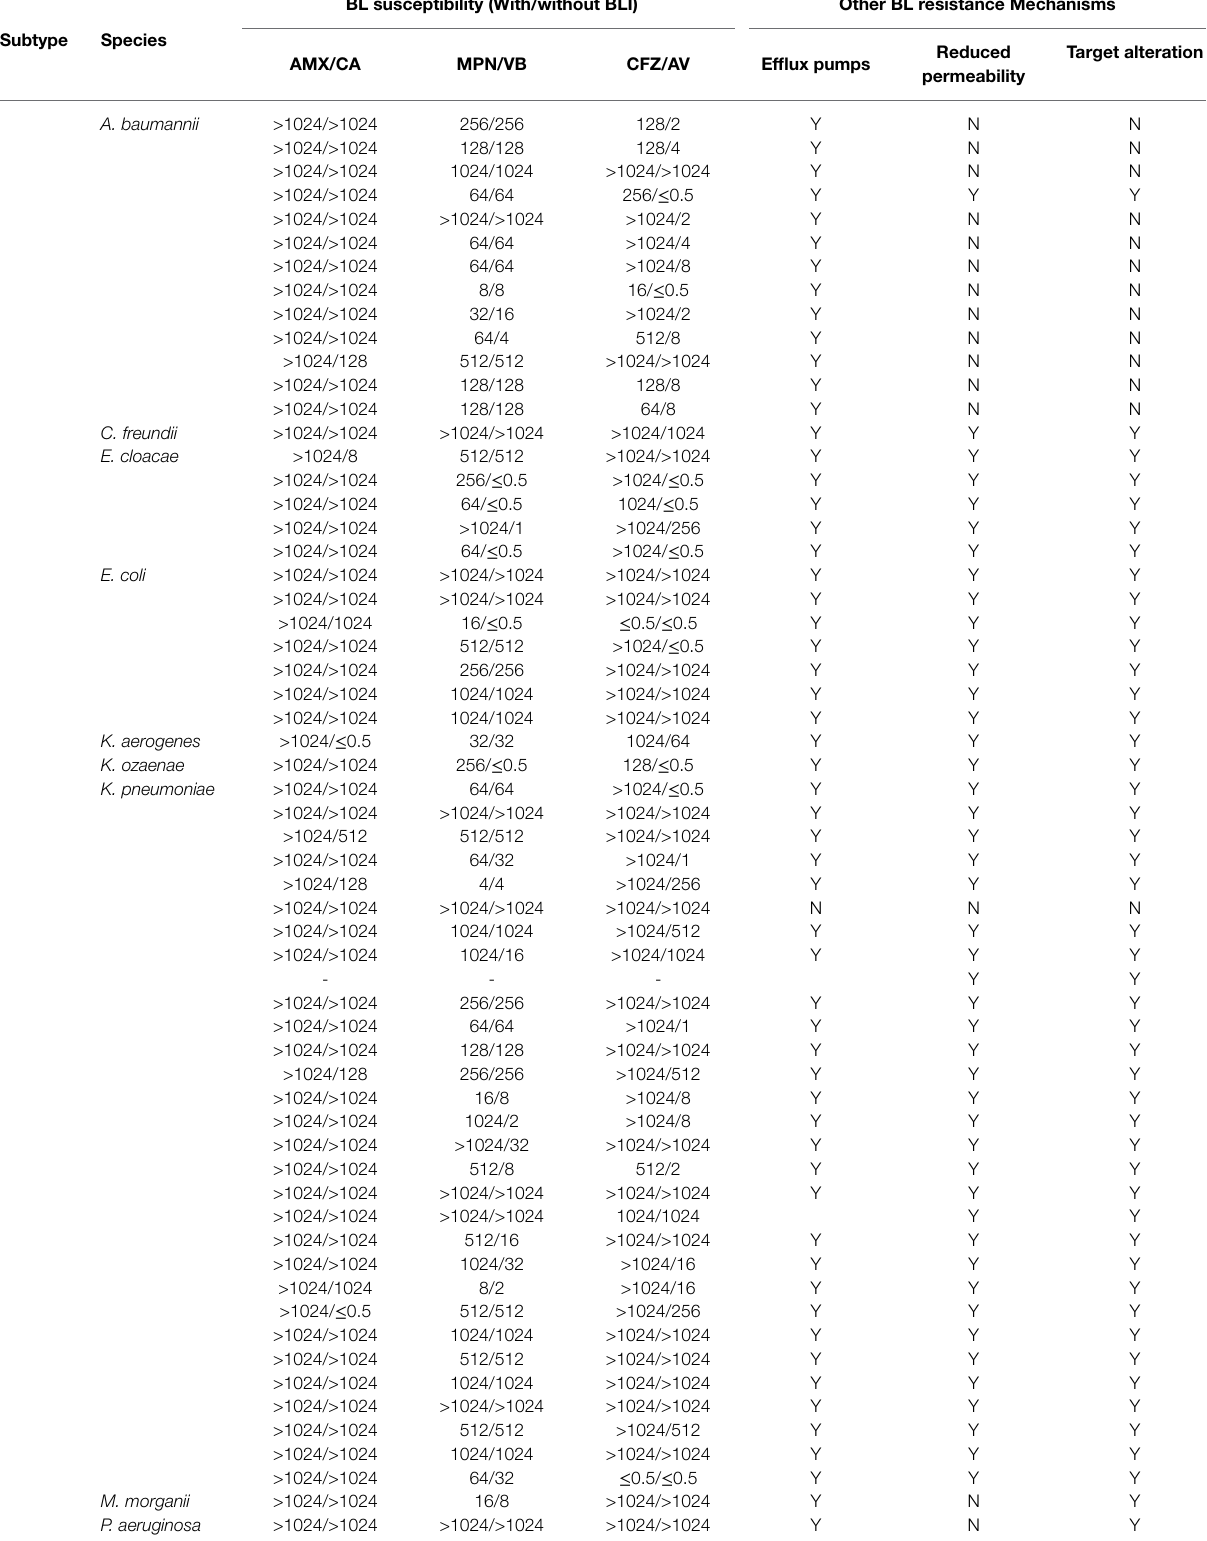
TABLE 3 | Class D Carbapenemase-producing isolates included in this